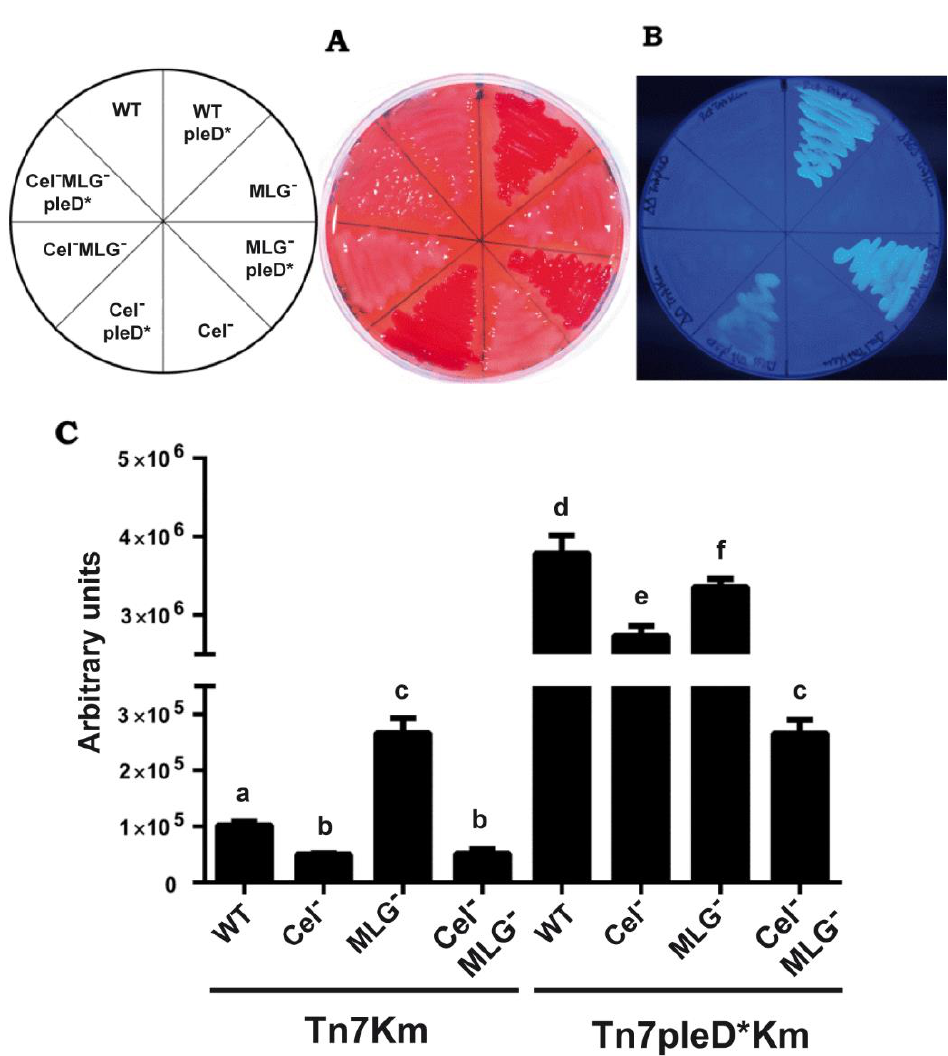
Figure 2. Contribution of cellulose and MLG to the CR + and CF + phenotypes of R. etli CFN42. Single mutants in celAB cellulose genes (Cel – ), in bgsA (MLG − ), the double mutant (Cel – MLG – ) and their respective parental strains (WT) with or without pleD* , were grown in minimal medium added with Congo Red (( A ) , 125 μg /mL) or Calcofluor (( B ) , 200 μg /mL). Plates were photographed after 48 h of growth at 28 °C. ( C ) Quantification of Calcofluor-derived fluorescence emitted by liquid cultures in minimal medium. Bars represent the mean of three biological replicates with three technical replicates ± standard deviation. Different letters over the bars indicate statistical significant differences with a p < 0.05.